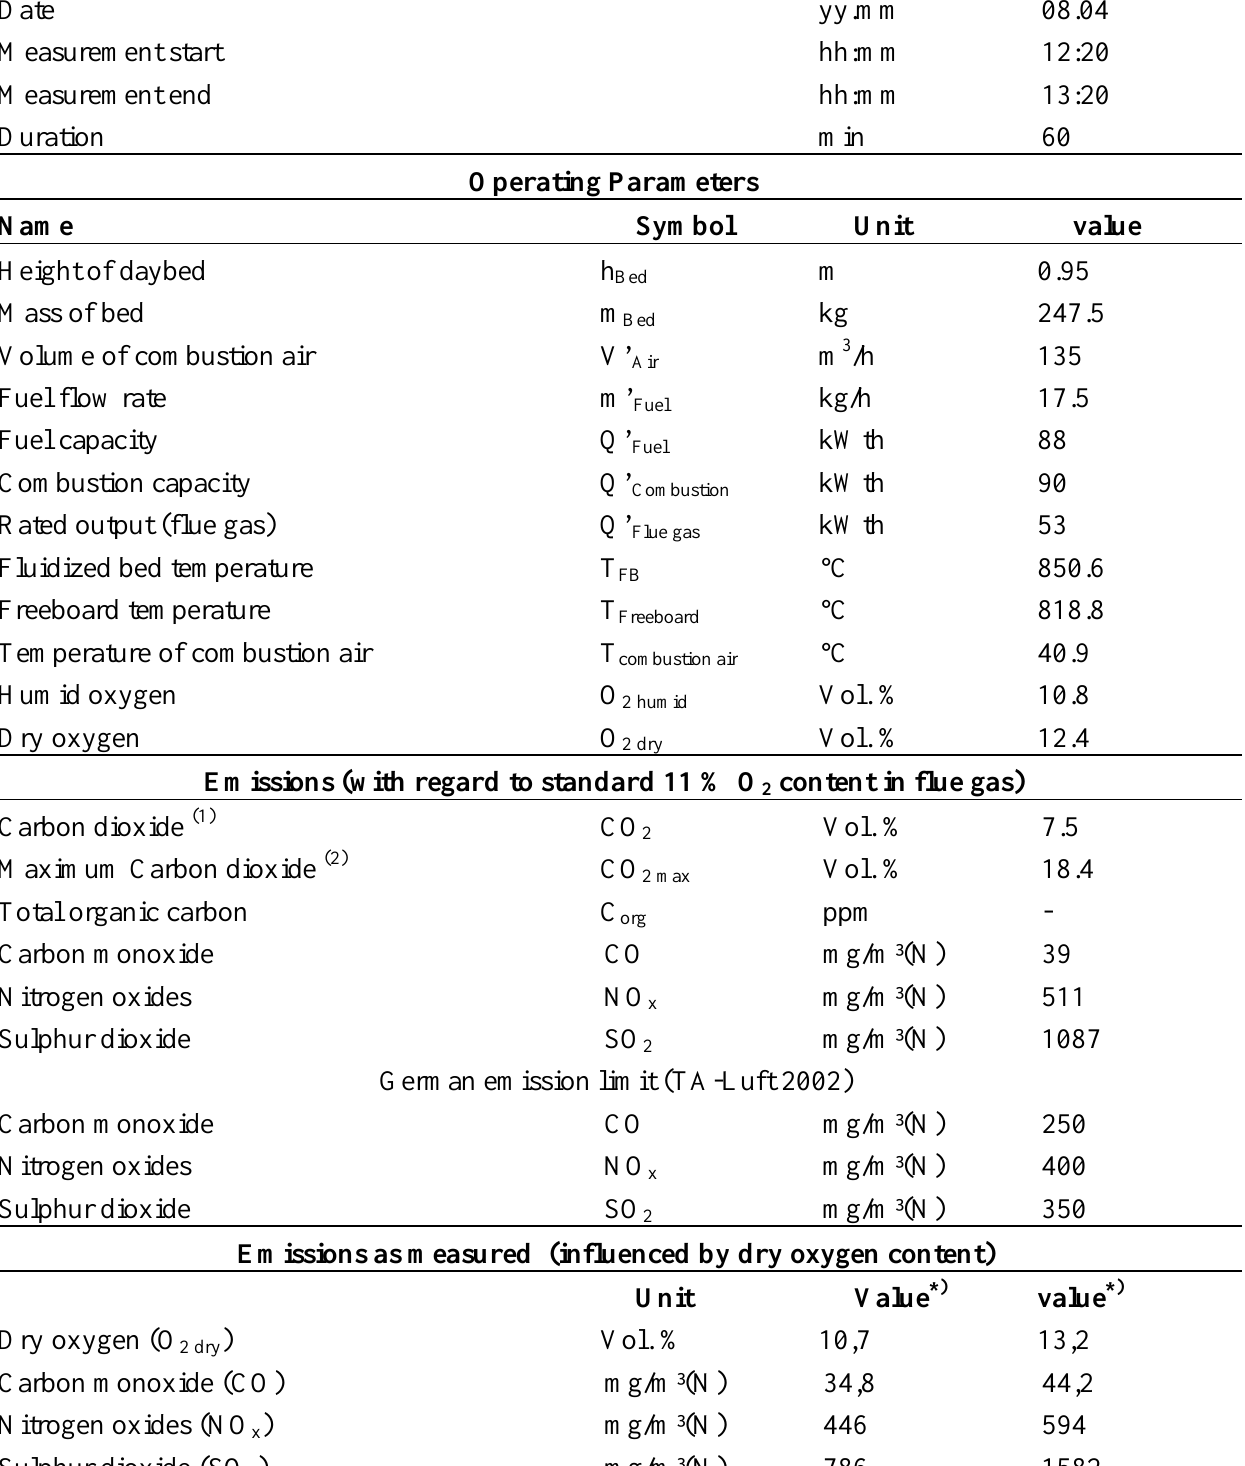
Table 4 . Process data and results of the experimental ER combustion